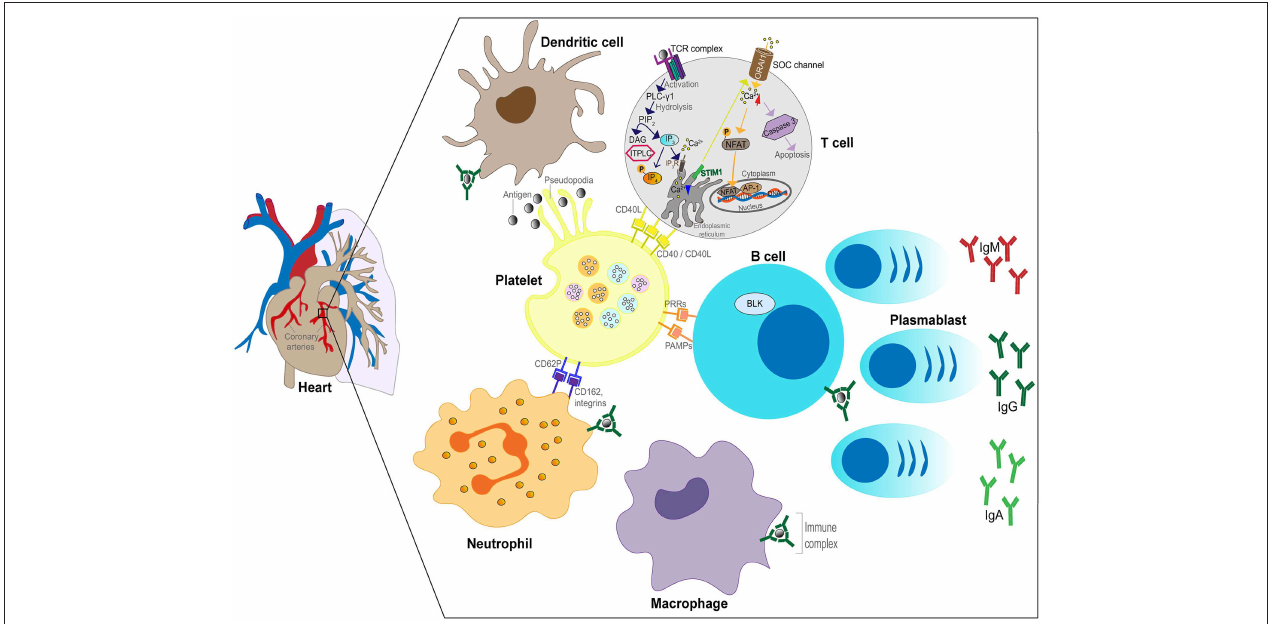
FIGURE 2 | Schematic of the role of ICs in the inflammatory process in KD . Plasmablasts produce antibodies (IgG, IgM, or IgA) against the unknown pathogen resulting in IC formation. ICs bind to FcRs expressed by neutrophils, B cells, DCs and macrophages leading to activation of the cells. Neutrophils invade the arterial wall followed by macrophages, DCs and T cells. ICs activate platelets releasing soluble mediators and binding to neutrophils. Phagocytosis of ICs by macrophages leads to antigenic peptide presentation and T cell